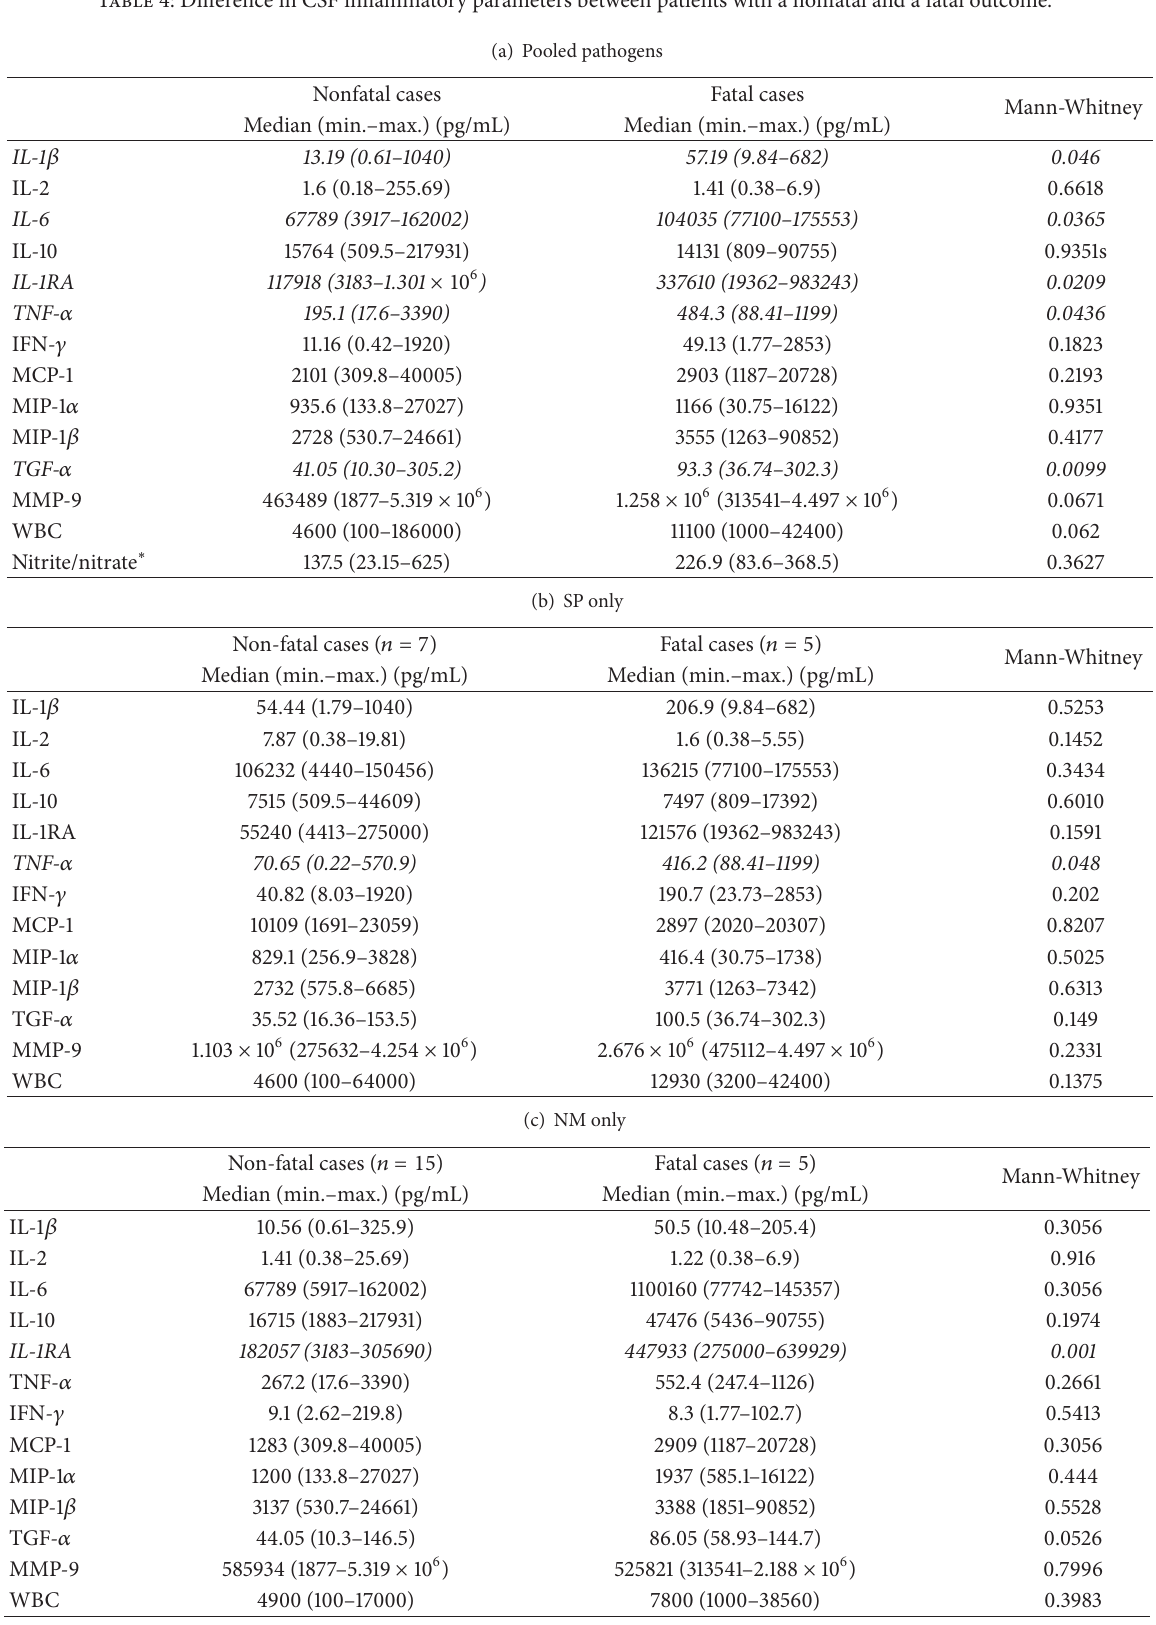
Table 4: Difference in CSF inflammatory parameters between patients with a nonfatal and a fatal outcome. (a) Pooled